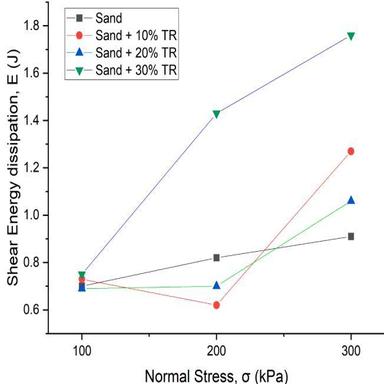
Shear energy dissipation (J) at different normal loading conditions for sand and sand-tyre mixes.